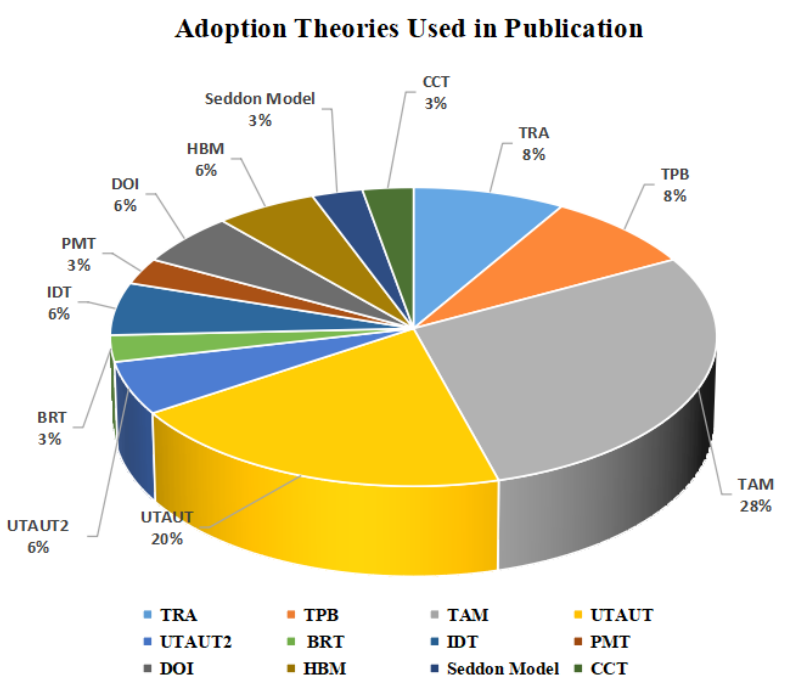
Figure 5. Adoption theories used in